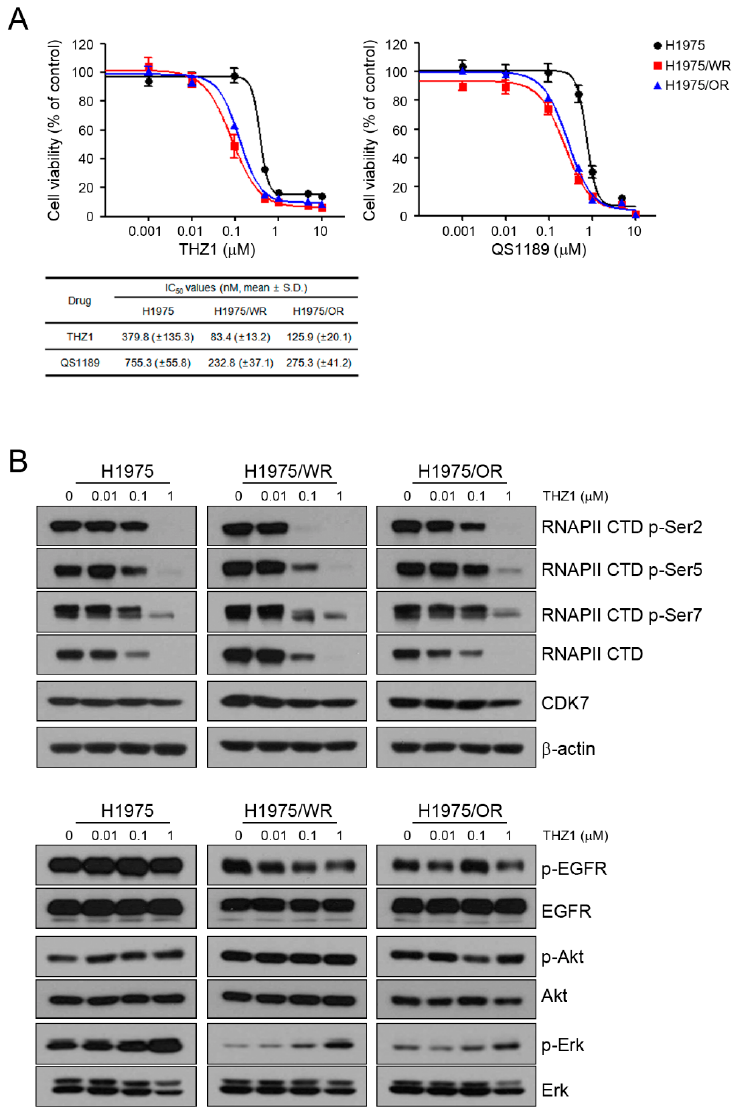
Figure 2. Effects of CDK7 inhibitors on cells with acquired resistance to WZ4002 or osimertinib. ( A ) Cells were treated with the indicated doses of THZ1 or QS1189 for 72 h, and cell viability was determined using MTT assays. The IC50 values of the CDK7 inhibitors were calculated. ( B ) Cells were treated with the indicated doses of THZ1 for 6 h. The indicated protein levels were analyzed by western blotting.